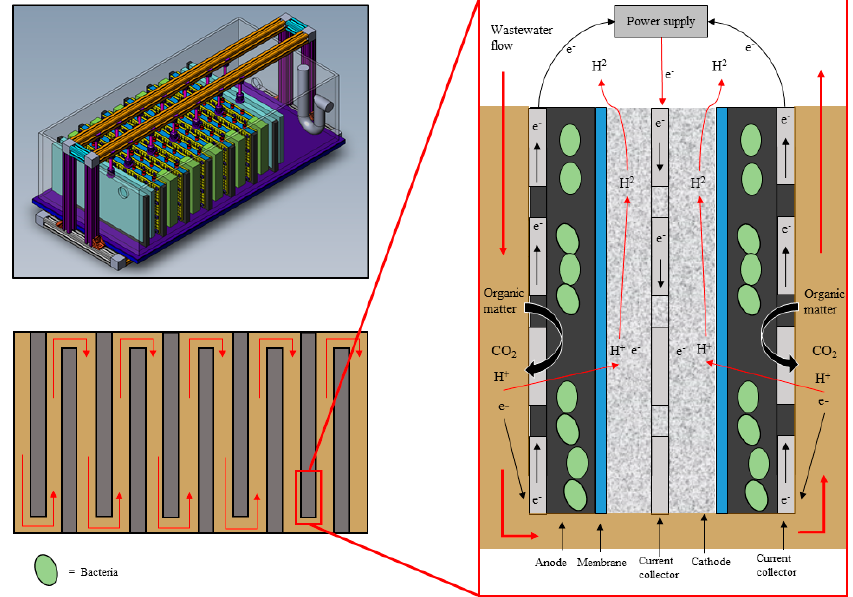
Figure 6. The pilot-scale MEC, showing the electrodes in the ‘cassette’ style design.